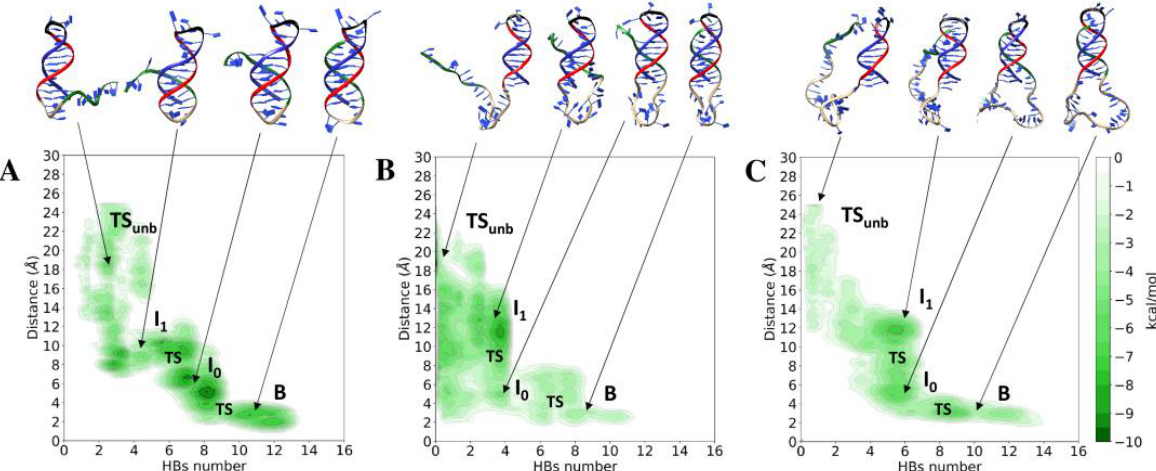
Figure 2. Iso-energetic contour of the free energy surface plotted as a function of the HB number established between the TFO and the DH, and of the distance between their centers of mass for the DIPRO5 ( A ), DIPRO15 ( B ) and DIPRO25 ( C ) systems. The upper structures are the representative configurations of the most populated clusters of the Bound (B), Intermediate (I 0 and I 1 ) and Transition (TS unb ) states, extracted from the trajectories. The color scheme follows that described in Figure 1.